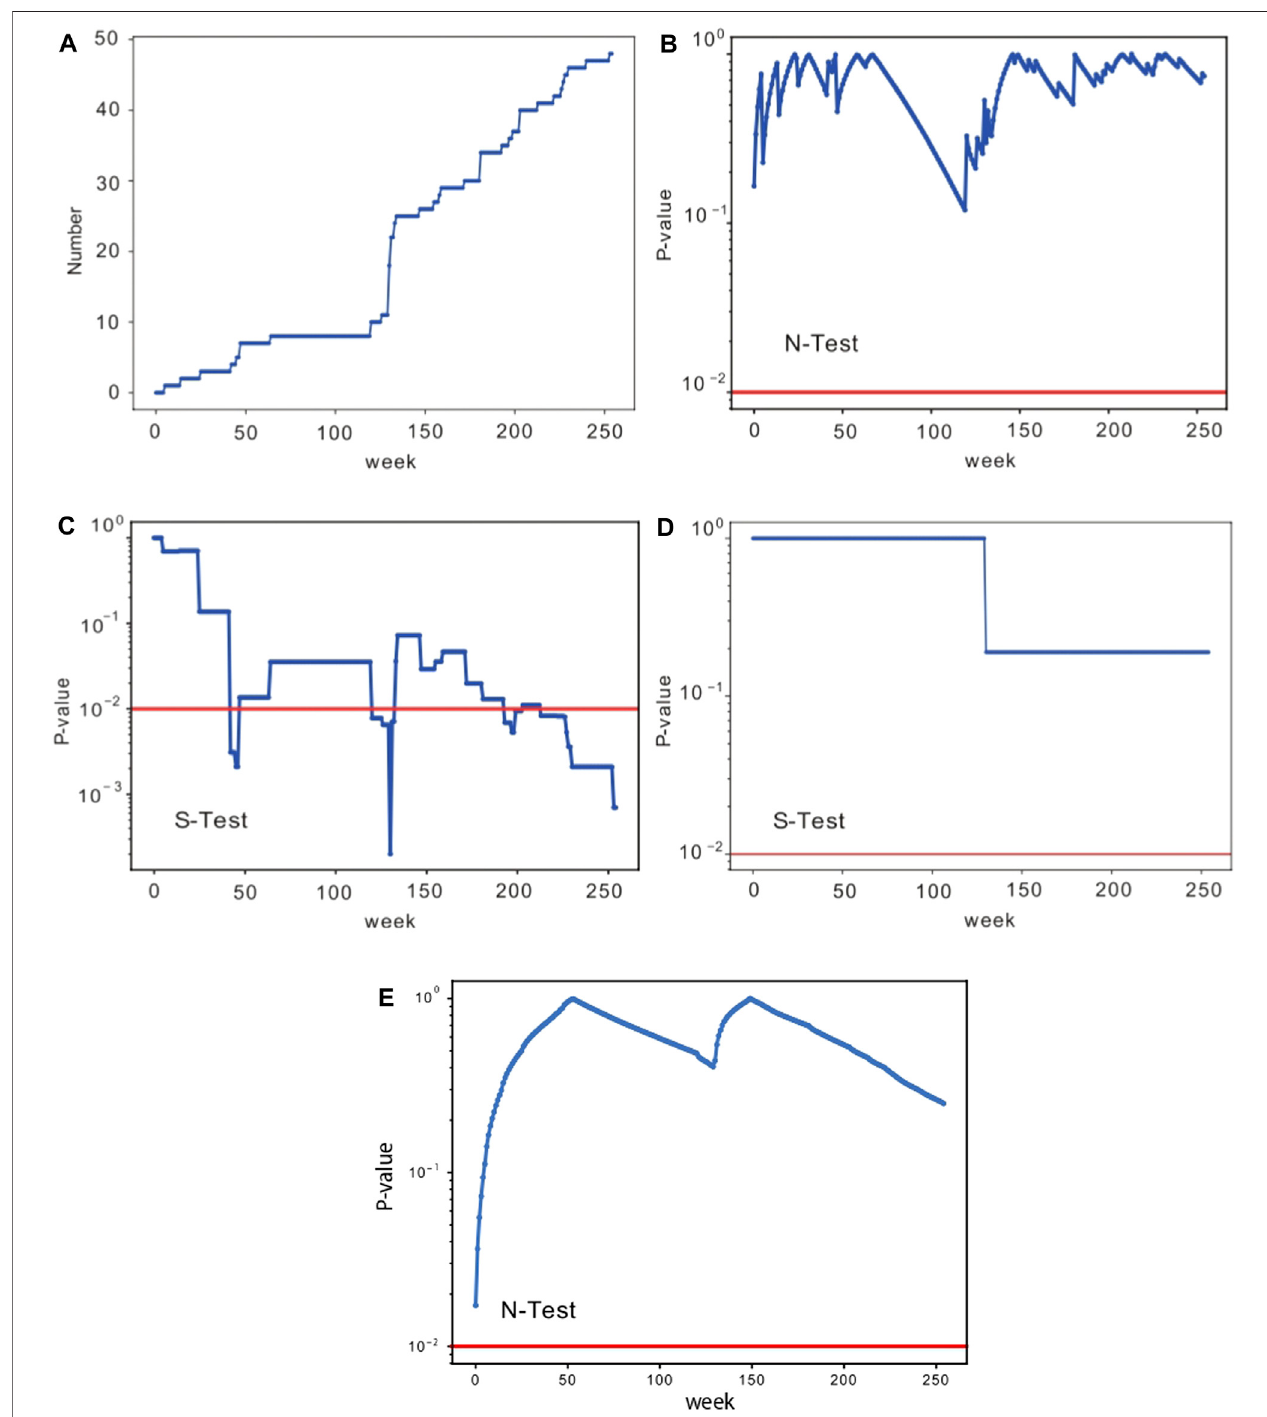
FIGURE 5 | (A) : cumulative number of M w ≥ 3 events in the Israeli catalog versus time. (B) and (C) : p-values versus time of the N- and the S-tests, respectively, obtained for the ETES model. The horizontal red lines indicate the 0.01 signi fi cance level. In all the plots, the x -axis represents the weeks starting from January 3, 2016. (D) and (E) : p-value of respectively the S- and N-test obtained for the ETES model with M w ≥ 4.